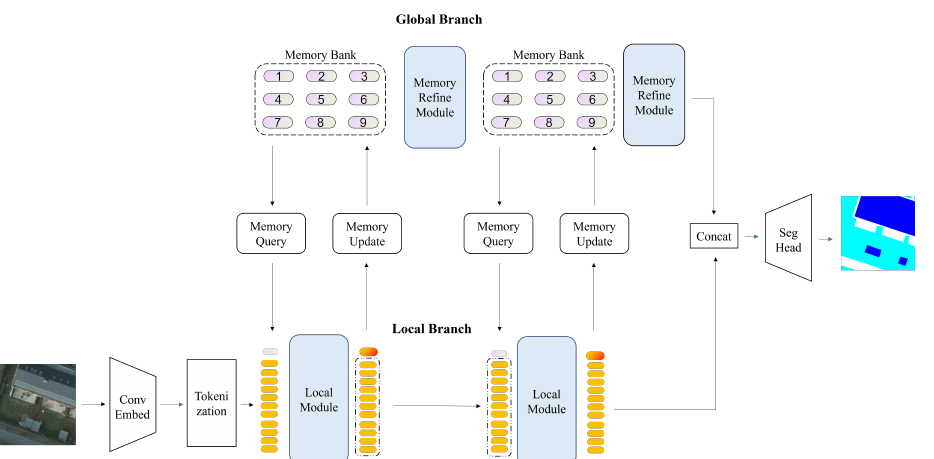
Figure 3. The proposed model for remote sensing segmentation. The MAT mainly consists of a global branch and a local branch. The global branch refines the memory bank, which is used as a representation of the prior and global information. The local branch extracts features from the input images. Bidirectional information flow between the two branches is enforced by the memory- query and memory-update modules. Then, the two branches’ output representation is fed into the segmentation head to perform segmentation prediction.